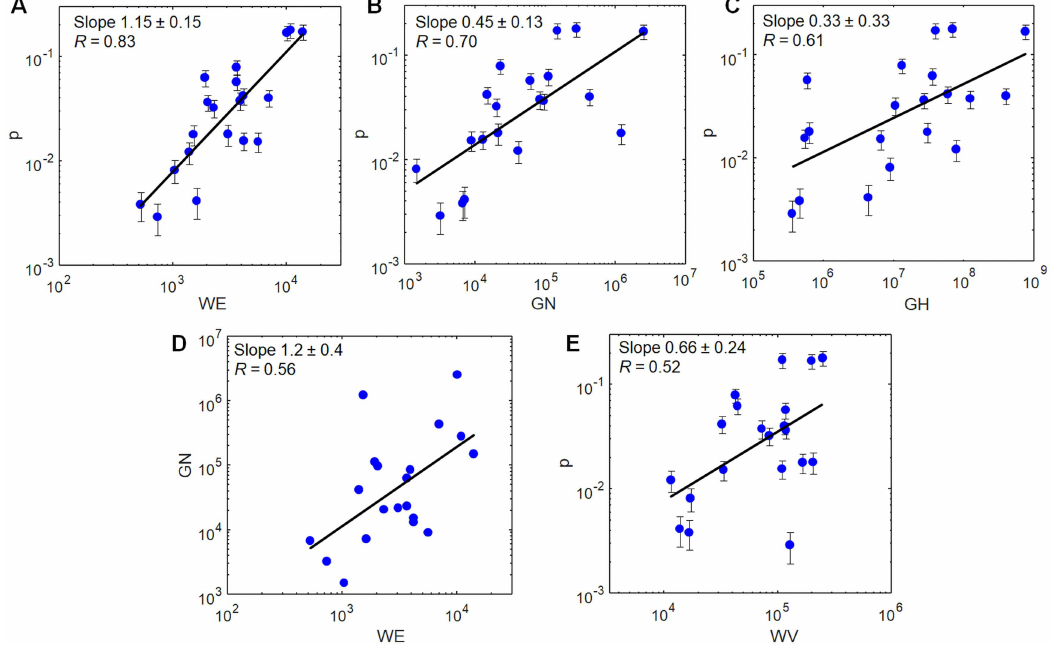
Fig 2. Correlations between quantitative measures of fame. Correlations between different quantitative measures of fame for the 20 individuals in Table 1. The survey metric p is compared with internet metrics WE (A), GN (B), GH (C), and WV (E). GN and WE are compared in (D). In each double logarithmic plot the slope of the best (least squares) fit line is indicated. Panels are presented in order of decreasing Pearson correlation R on the double log plot. Error bars for p are obtained from bootstrap analysis.